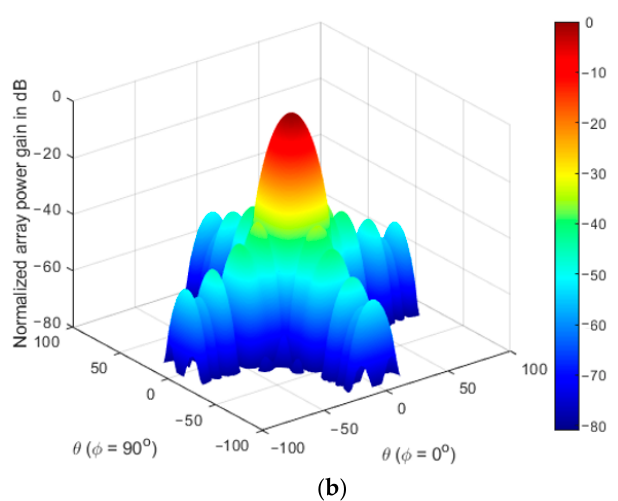
Figure 7. ( a ) 2D cross-linear extrapolated Blackman window for 16 × 16 array. ( b ) Normalized array power pattern.